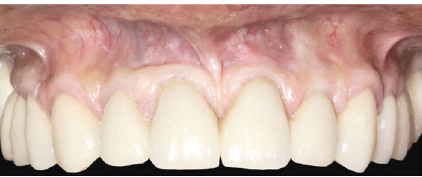
Figure 19: De fi nitive restoration 2 years after the